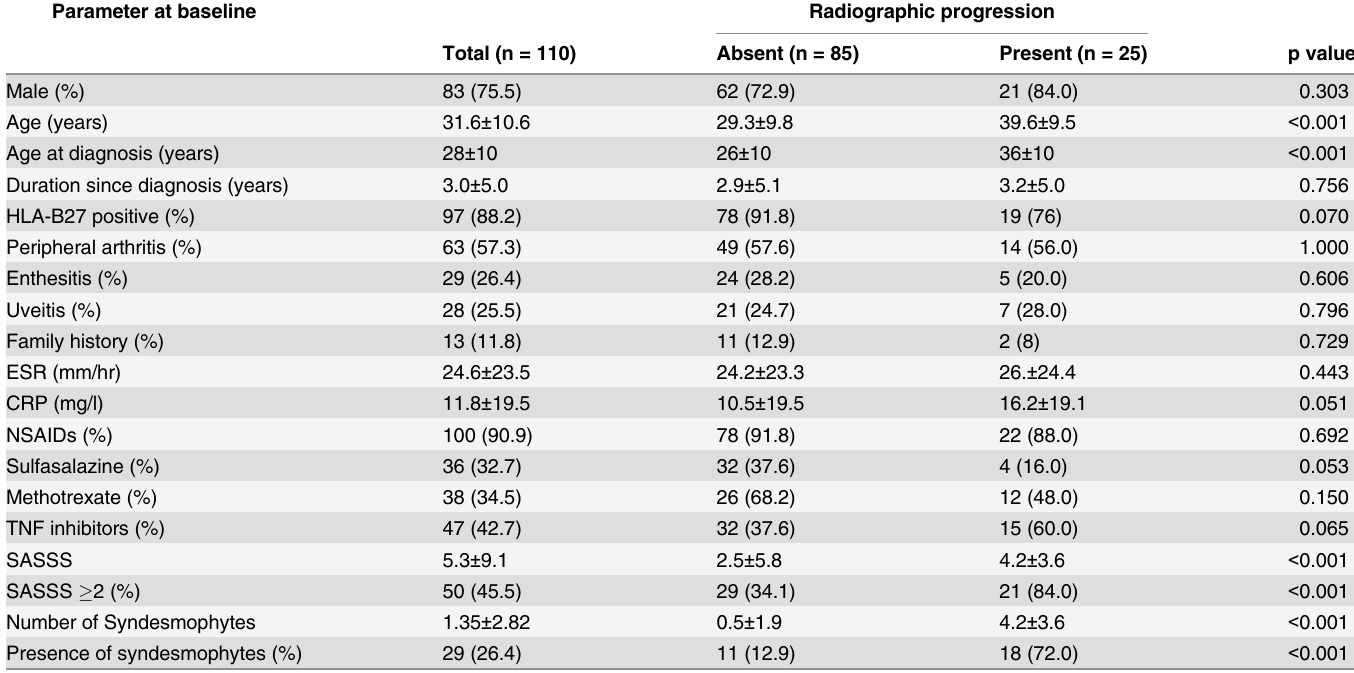
Table 1. Baseline characteristics of patients with axial spondyloarthritis.